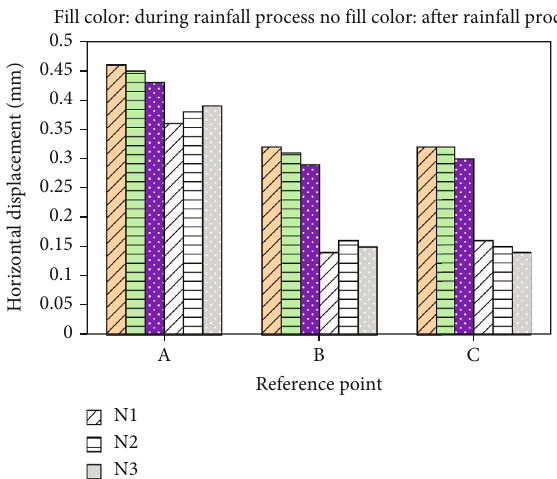
Figure 21: Di ff erent values of horizontal displacement at the reference point for di ff erent vegetation densities.